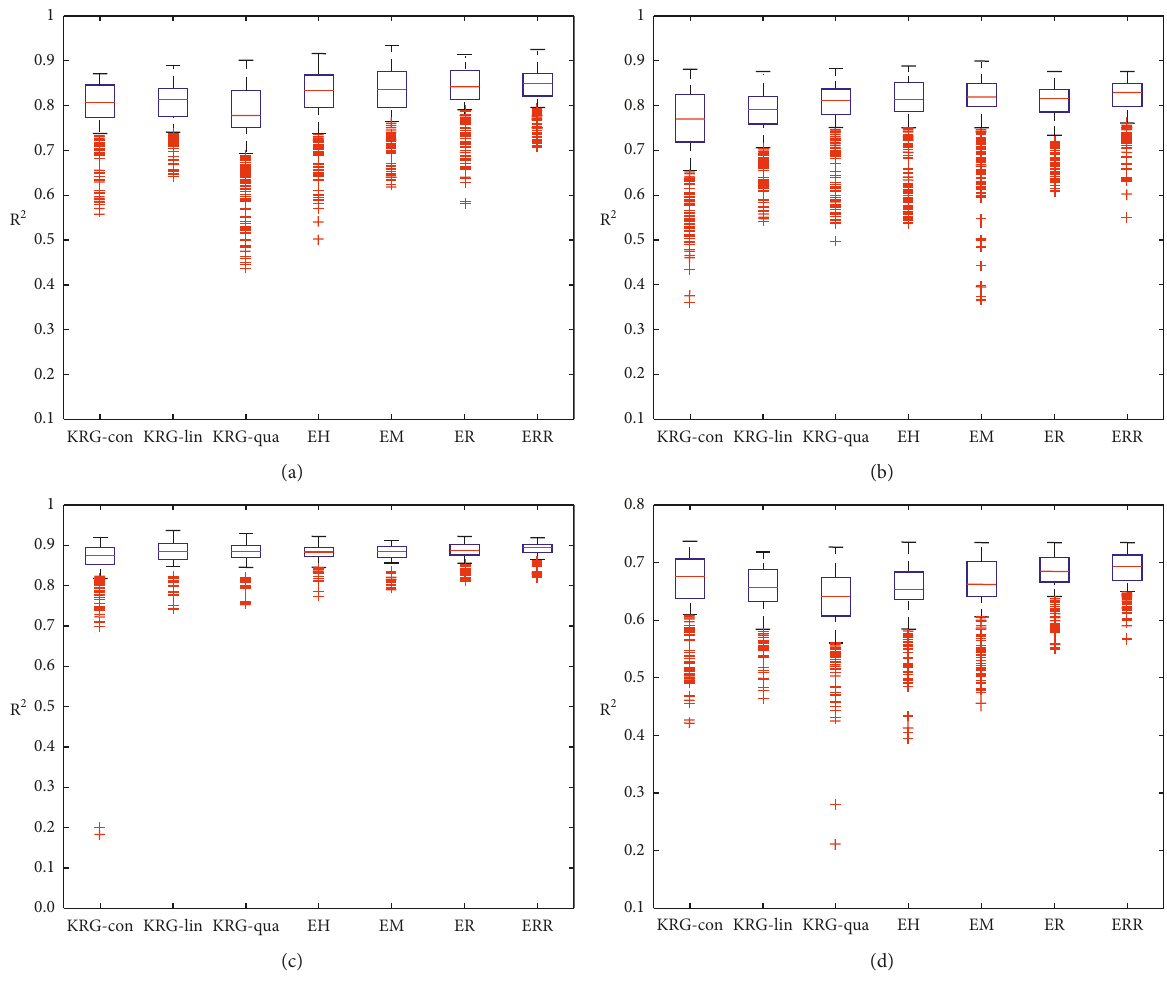
Figure 4: Coefficients of determination for different surrogate models. (a) Numerical Example 1. (b) Numerical Example 2. (c) Numerical Example 3. (d) Numerical Example 4. Table 3: Mean and ψ value of R 2 using different metamodeling models for all test